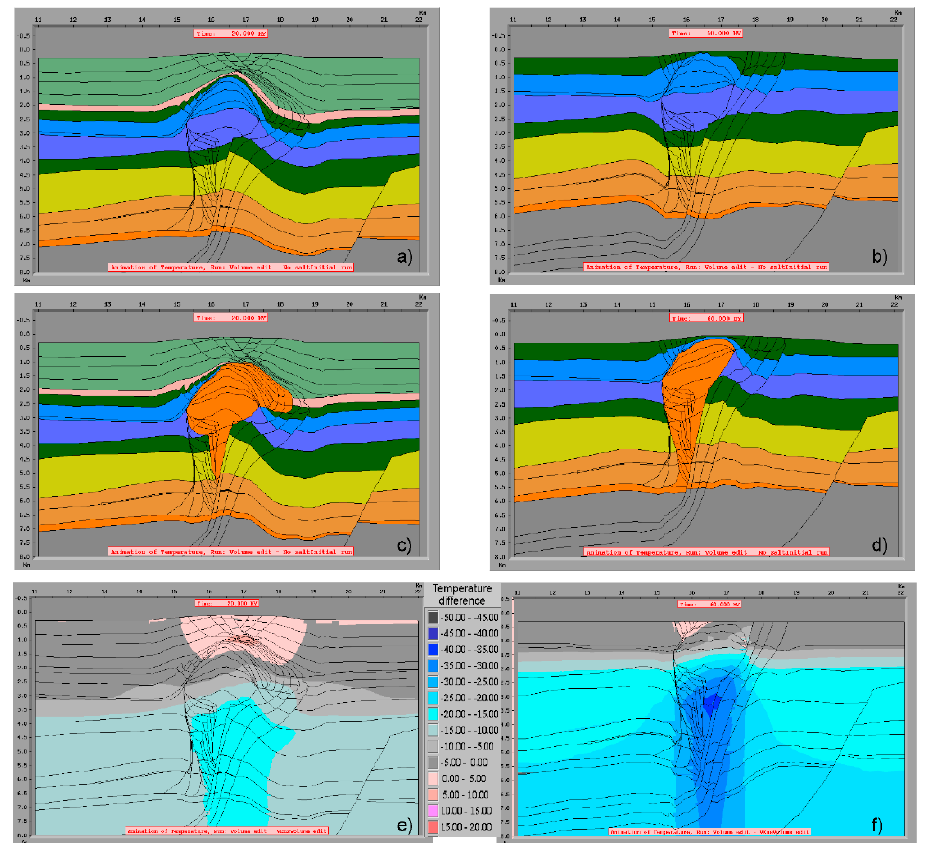
Figure 16. ( a – d ) Reconstructed geometries at 20 Ma ( a , c ) and 60 Ma ( b , d ) without and with salt structures, Figure ( e , f ) shows the temperature di ff erences between the two models; temperature cooling in blue colous and temperature increase as pink to red